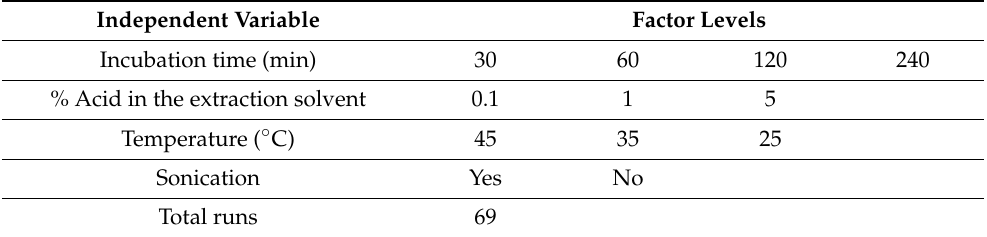
Table 1. Independent variables and their values used for the model